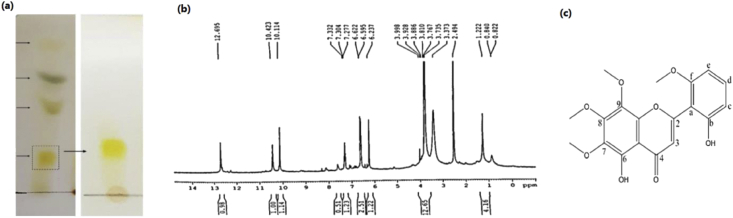
(a) Isolation pattern of DCMex (left) and neobaicalein (right) on TLC. (b) 1H-NMR spectrum of neobaicalein: 1H-NMR (DMSO, 300 MHz) δ: 12.7 (1H, s, OH-6), 10.4 (1H, s, OH-b), 7.3 (1H, dd, J = 8.4, 8.1 Hz, H-d), 6.6 (2H, m, H-c, H-e), 6.2 (1H, s, H-2), 3.8 (12H, s, O–CH3-7,8,9,f). (c) The chemical structure of neobaicalein. The full non-adjusted TLC image is provided in the supplementary material (Figure S1).